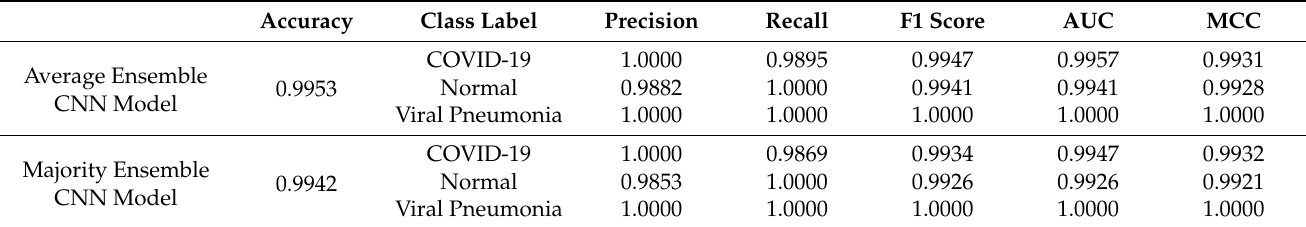
Table 3. Evaluation Metrics for Voting Ensemble CNN Models.